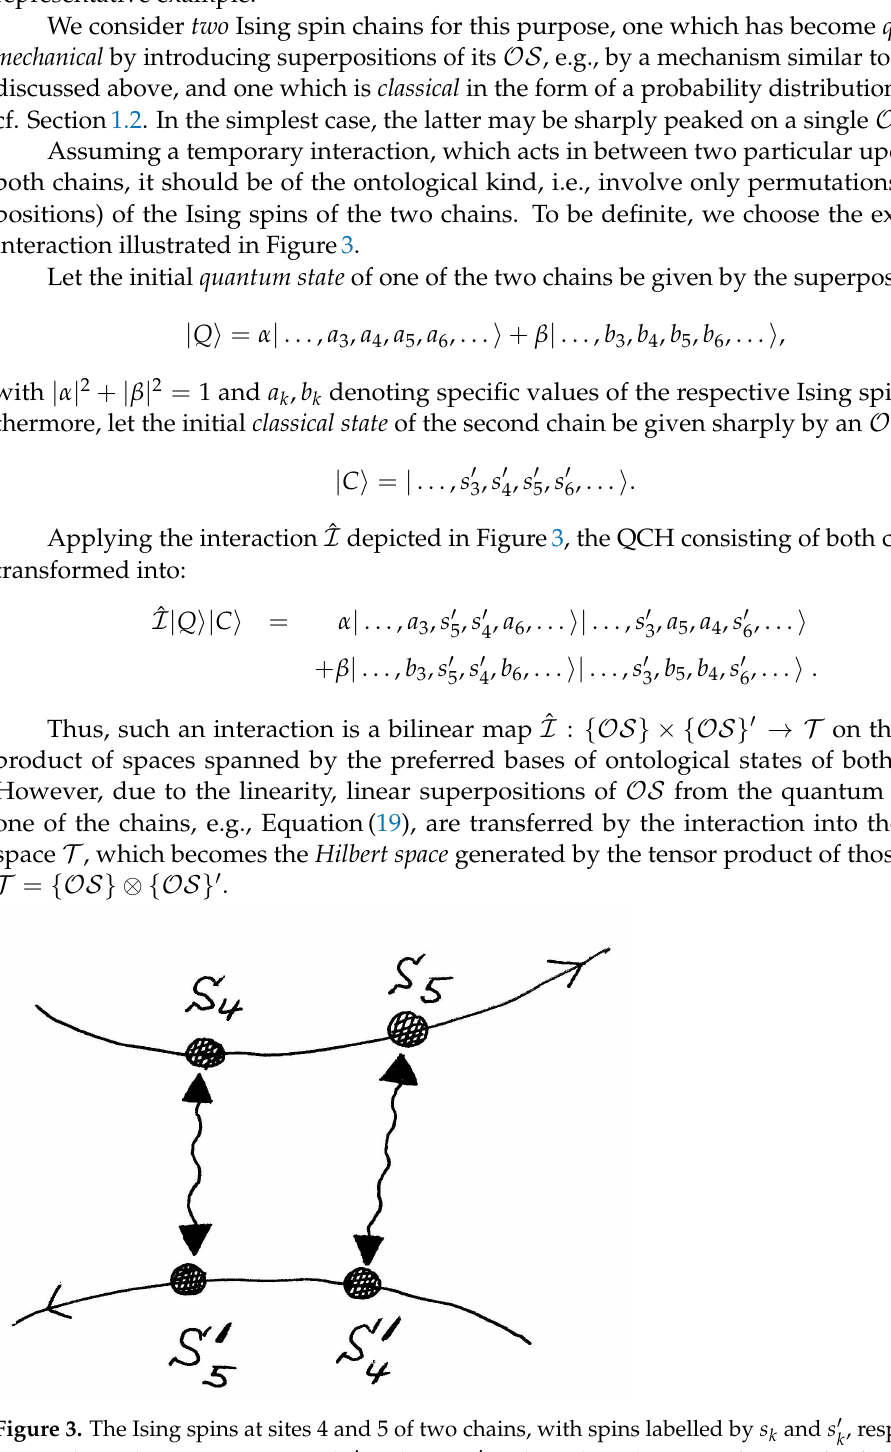
and spins s (cid:48) and s 5 . Thus, the states of a pair of rightmovers are 5 4